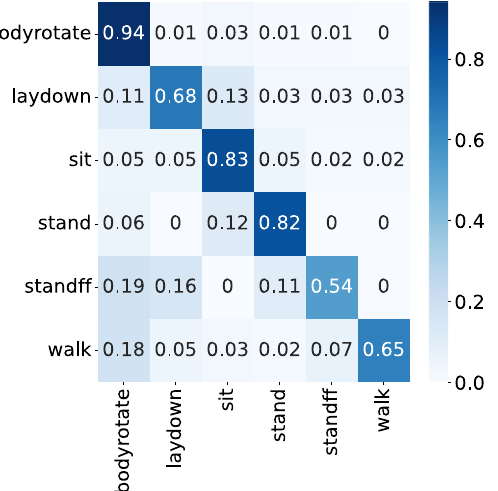
Figure 3. Confusion matrix of Human Activity Recognition (HAR) classification using our SFLR model (with compressed sensing). Ten labelled examples per class are